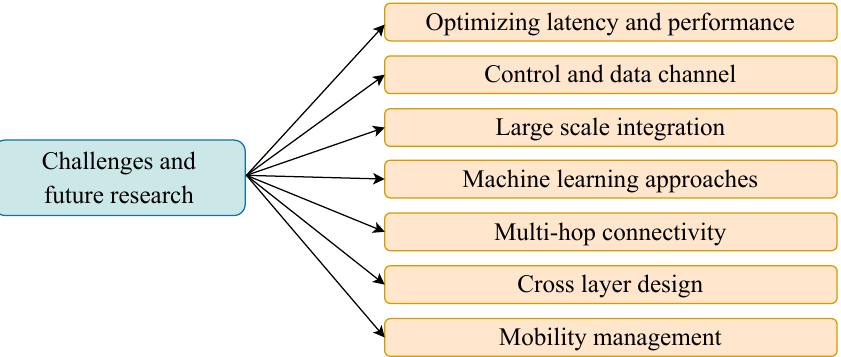
Figure 9. Challenges & future research